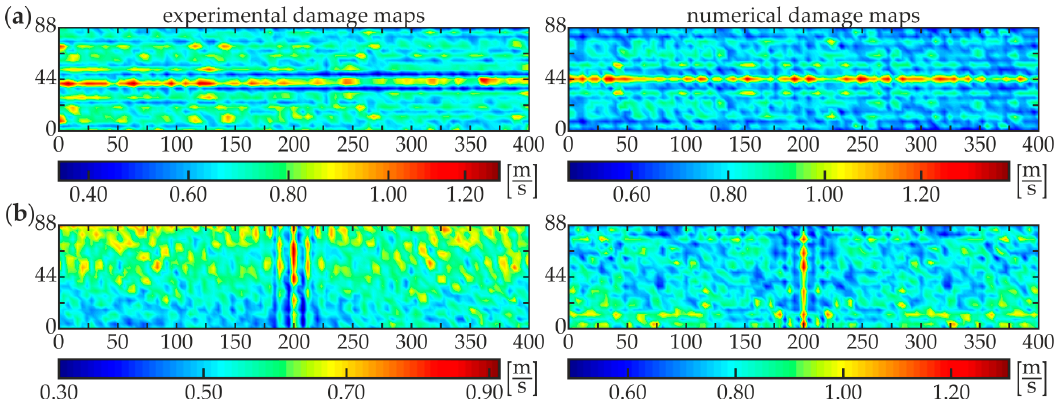
Figure 13. Experimental and numerical WRMS damage maps for specimen #5: ( a ) excitation P3 and ( b ) excitation P4.